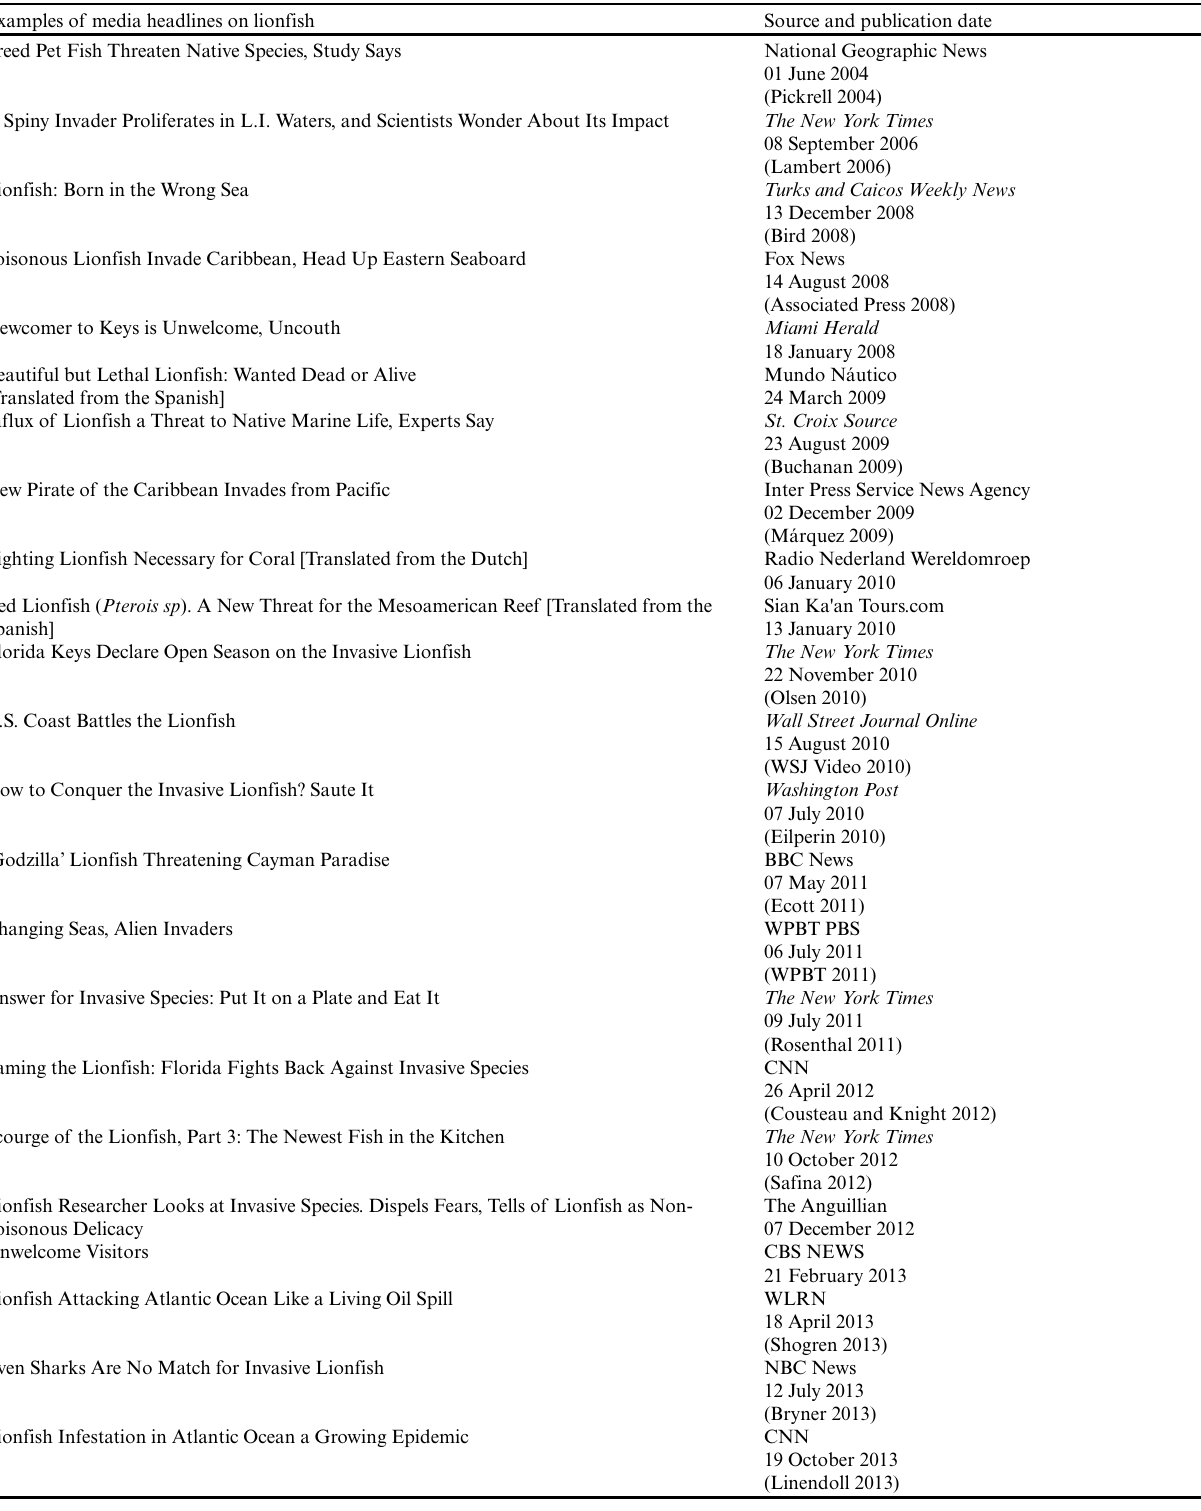
Table 3 . Media discourse on Western Atlantic lionfish ( Pterois